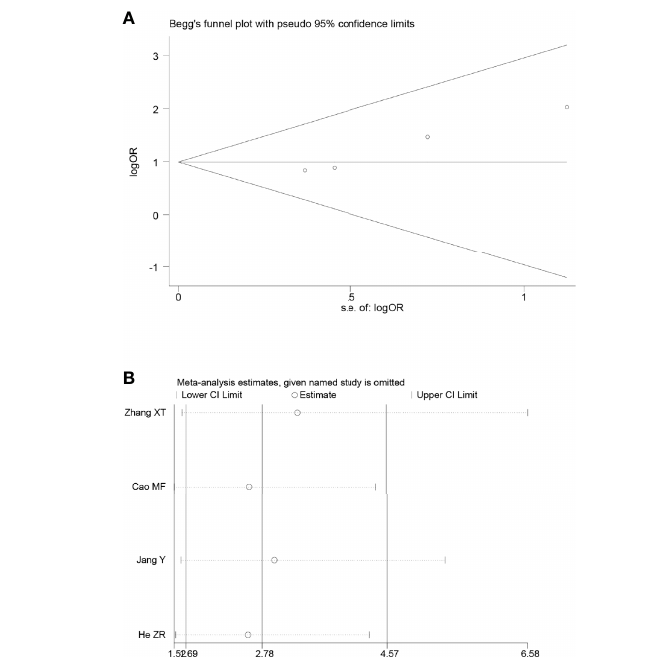
FIGURE 9 Begg ’ s funnel plot (A) and sensitivity analysis (B) of all the included studies for the analysis of PR. .